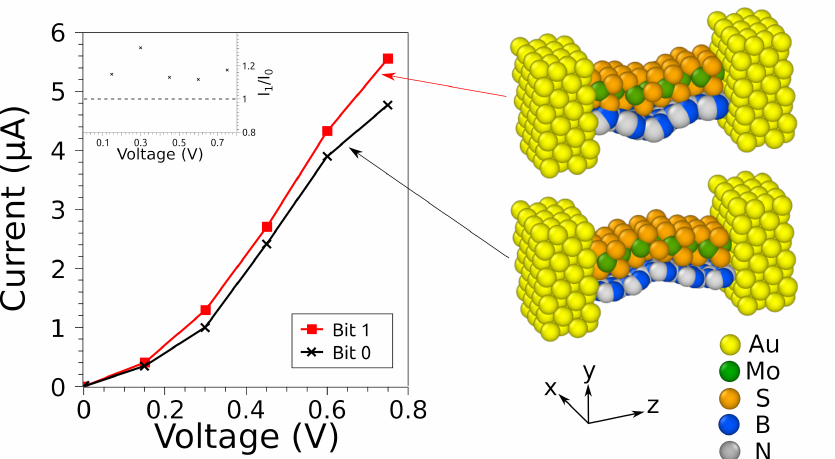
Figure 4. Current–Voltage characteristic curve of the heterostructure configuration for a compression of ≈ 5%. The current increased increasing the voltage bias across the device. For the two different configurations, pictured on the right, two different values of current for the same voltage are achieved. Inset shows the ratio I 1 / I 0 , showing ≈ 20% difference in current flowing across the device between the two states, for all voltage